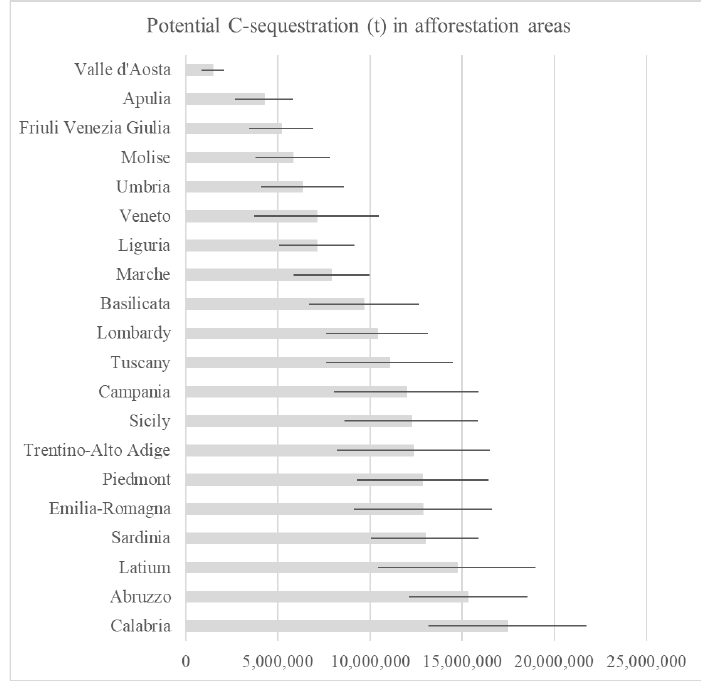
Figure 5. Potential C-sequestration (t) and 95% CI width (t) for administrative regions in afforestation areas between 1985 and 2019. The value represents the potential carbon that would be sequestrated when the trees in the afforestation areas mature.